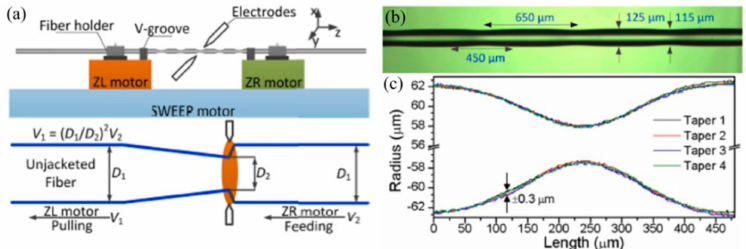
Figure 18. ( a ) Schematic diagram for inscribing a LPFG with periodic tapers; ( b ) side-view microscope images of periodic taper; ( c ) shape profiles of four tapers